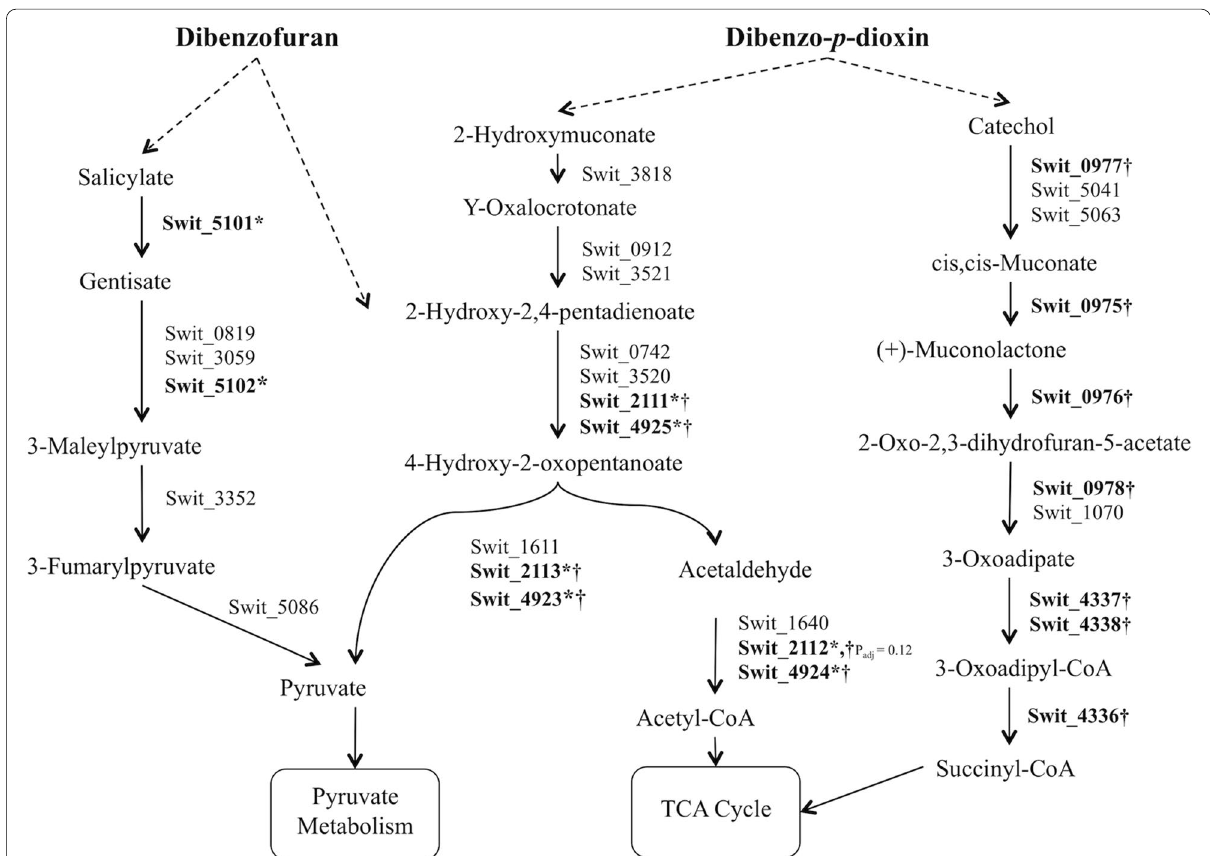
Fig. 5 The lower catabolic pathway for DBF and DD degradation. Upregulated genes are indicated in bold, (*) with DBF and (†) with